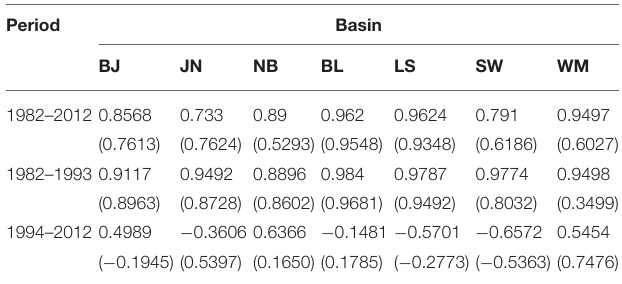
TABLE 1 | Correlation between tidal prism and cross sectional area in individual basins. Period